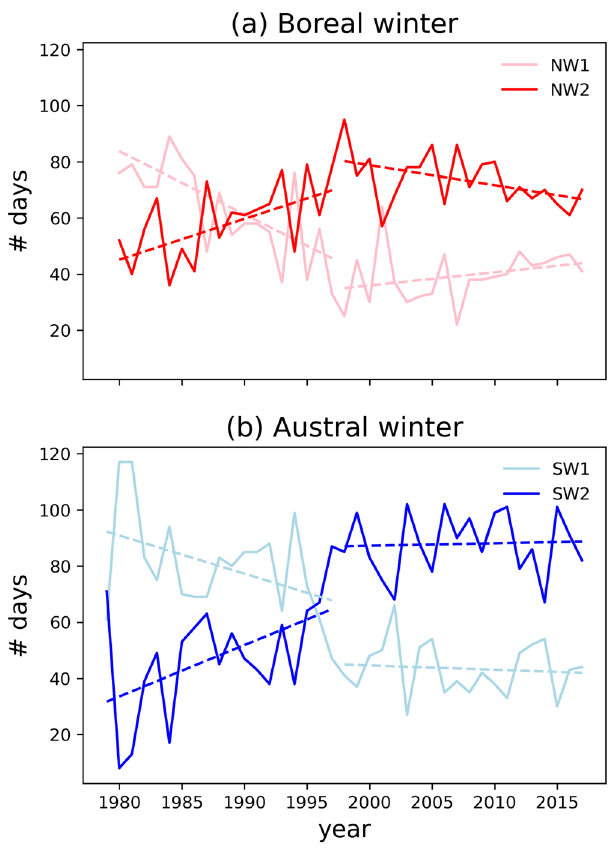
Fig. 4 Trends in cluster occurrence. (solid lines) Cluster occurrences for ( a , pink and red) NW 1 and NW 2 and ( b , dark and light blue) SW 1 and SW 2 in each year (days). NW 1 and NW 2 occurrences in November and December are counted in the next year. Dashed lines show linear trends for periods prior to 1998 and post